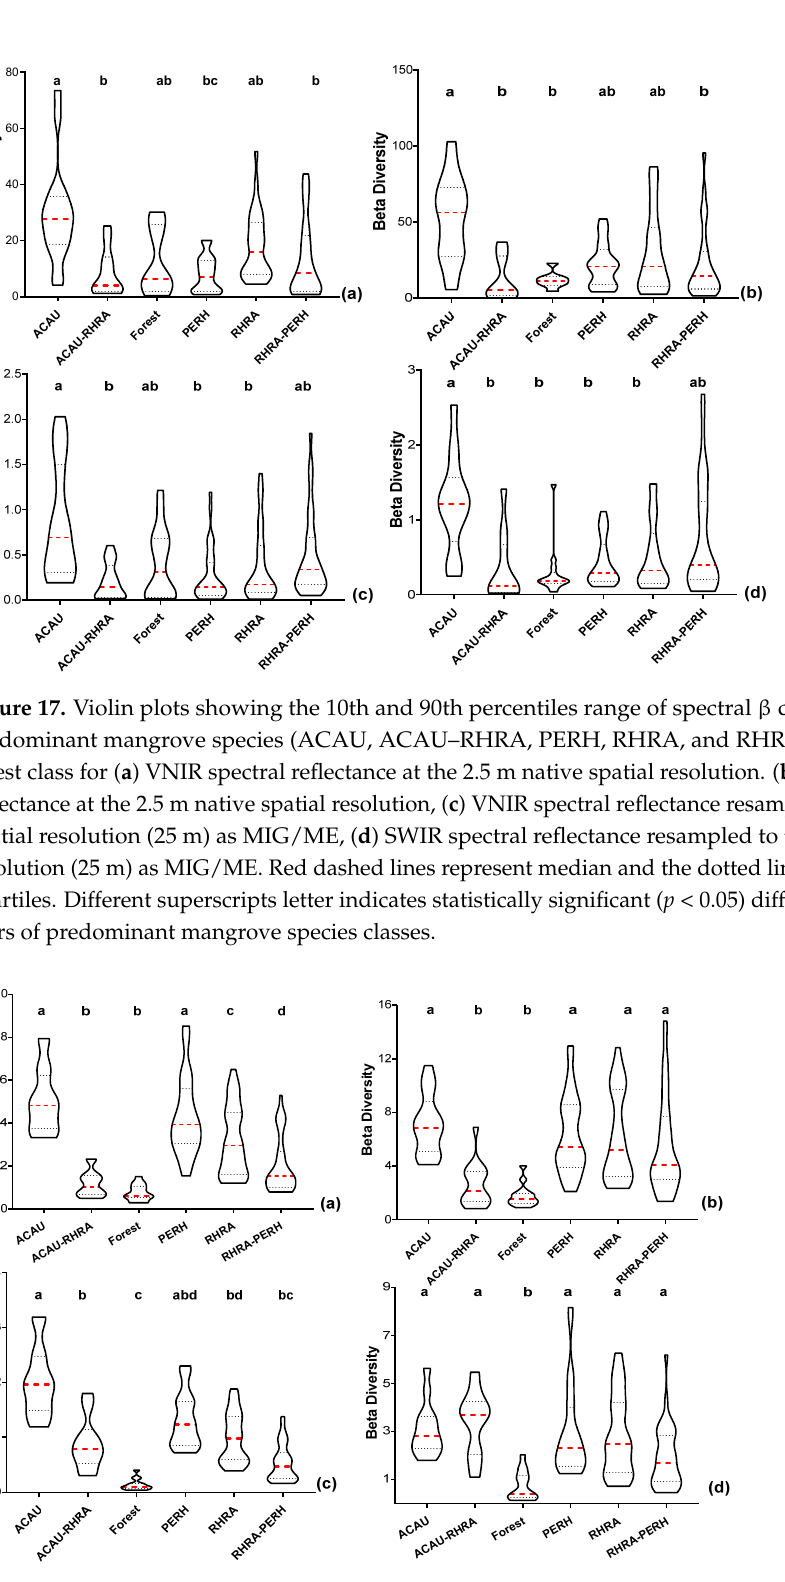
Figure 18. Violin plots showing the 10th and 90th percentiles range of spectral β diversity computed from the SCM at 25 m spatial resolution. Each box represents one of the five predominant mangrove species classes (ACAU, ACAU–RHRA, PERH, RHRA, and RHRA–PERH) and a forest class. ( a ) MIG–VNIR, ( b ) ME–VNIR, ( c ) MIG–SWIR, and ( d ) ME–SWIR. Red dashed lines represent median and the dotted lines represent the quartiles. Different superscripts letter indicates statistically significant ( p < 0.05) differences between pairs of predominant mangrove species classes.